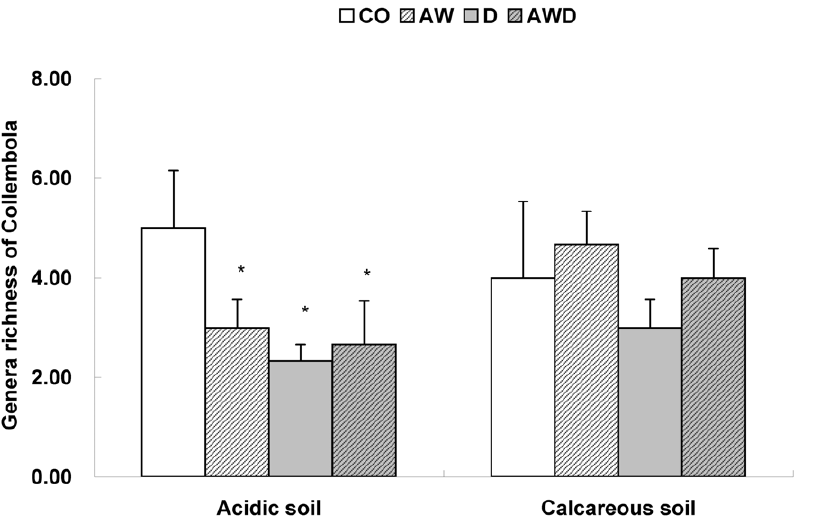
Figure 3. Effects of climate treatments and soil types on Collembola richness. Effects of the treatments (CO=control, AW=air warming, D=drought, and AWD=air warming + drought) on the genus level richness (number of genera) of Collembola in two forest soils (acidic and calcareous) in the Querco experiment at WSL in 2007, with mean values + SE, where * indicates significant differences from CO ( P , 0.05, n=3).